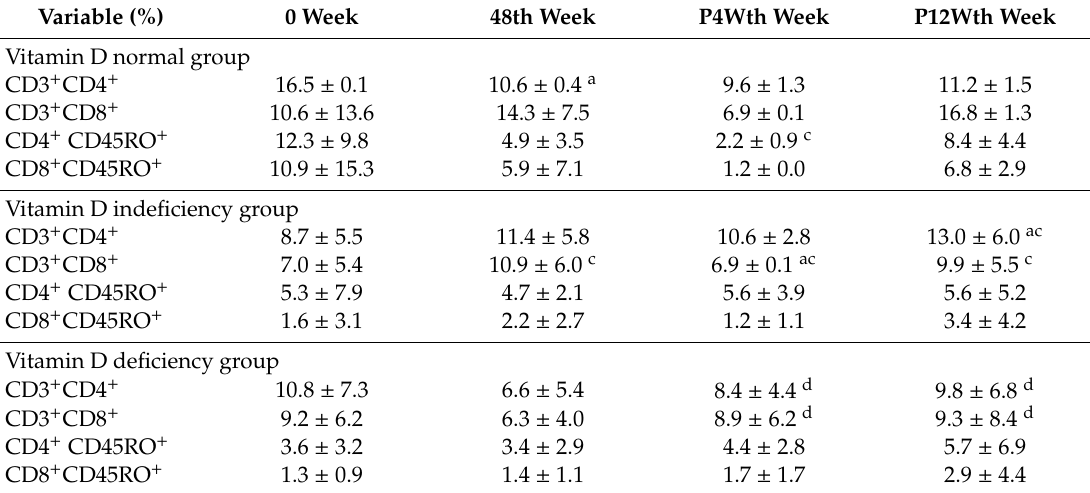
Table 5. E ff ect of serum vitamin D concentration on CD marker data during oligo fucoidan